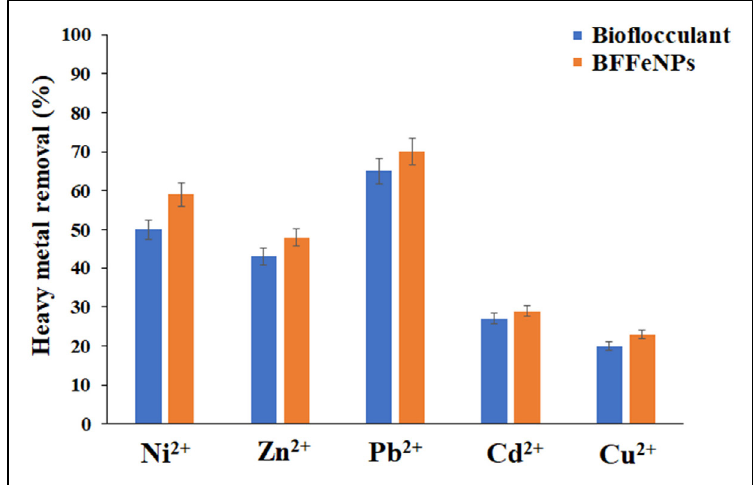
Fig. 3. Heavy metal removal from simulated